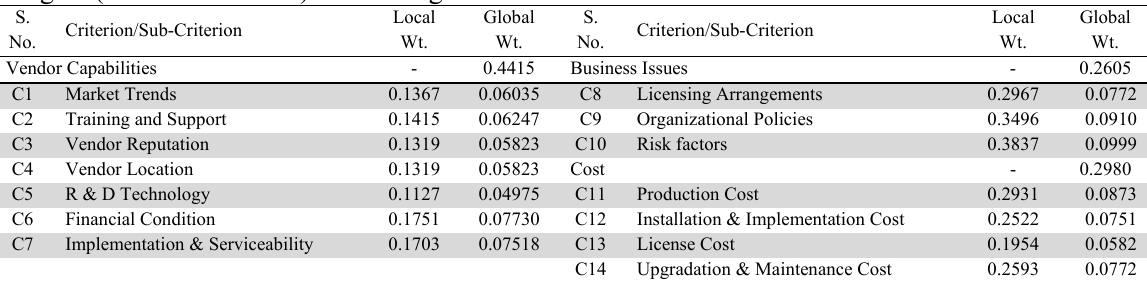
Table 1 Weights (Local and Global) for ranking criteria S. No.